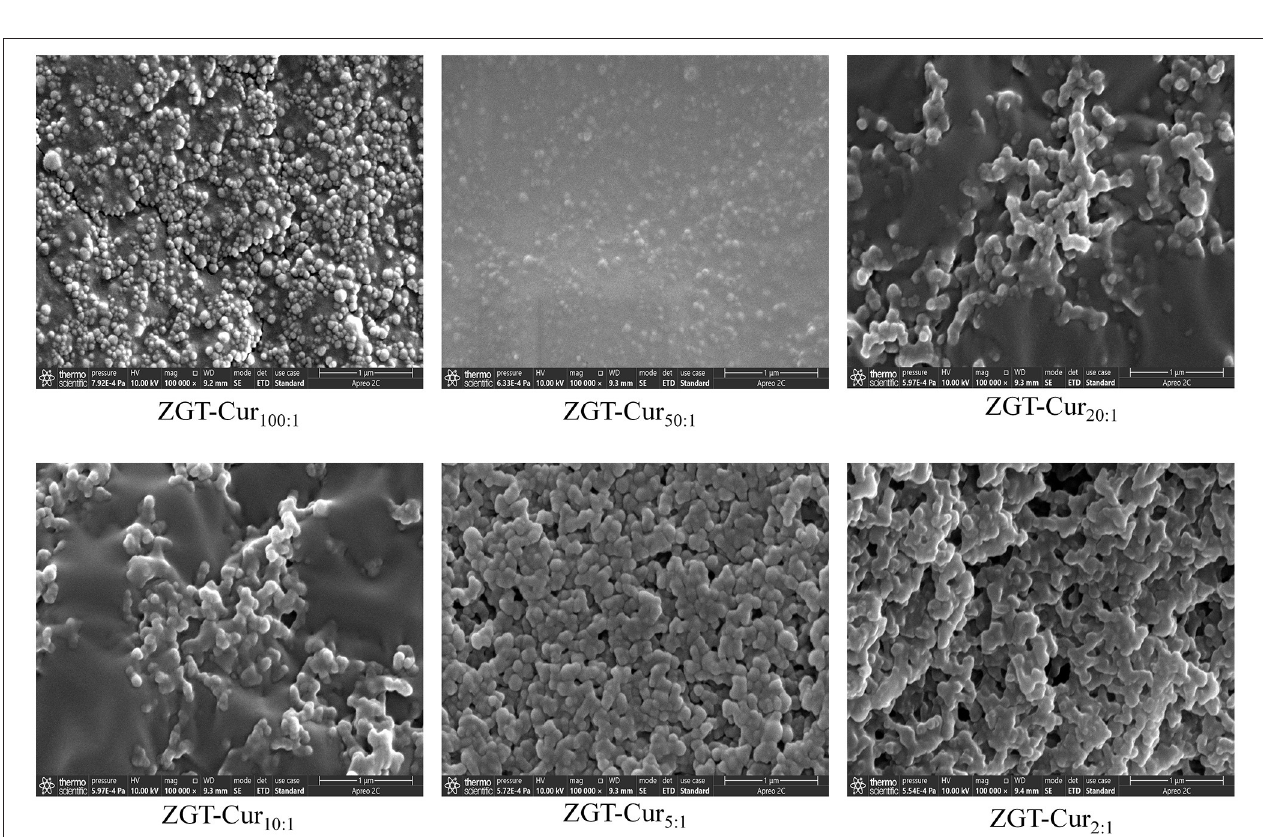
FIGURE 2 | Microstructure of ZGT-curcumin (Cur) composite particles with a different mass of zein to Cur.